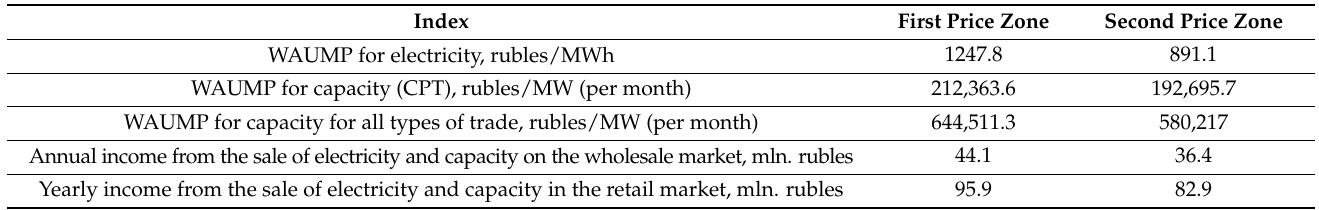
Table 5. Maximum income of an SPP in the price zones of the wholesale electricity market and the retail market.